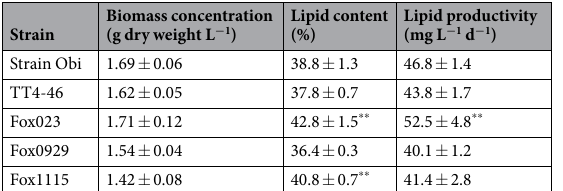
Table 2. Lipid productivity in FAT1 -overexpressed strains. The data are shown as mean ± standard deviation of triplicates. The biomass dry weights and lipid contents were determined 14 days after the start of the cultivation. Statistical significance of differences between strain TT4-46 and the FAT1 -overexpressed strains was tested by Student’s t-test (two tailed), and the results are shown as asterisks. Two asterisks indicate P <